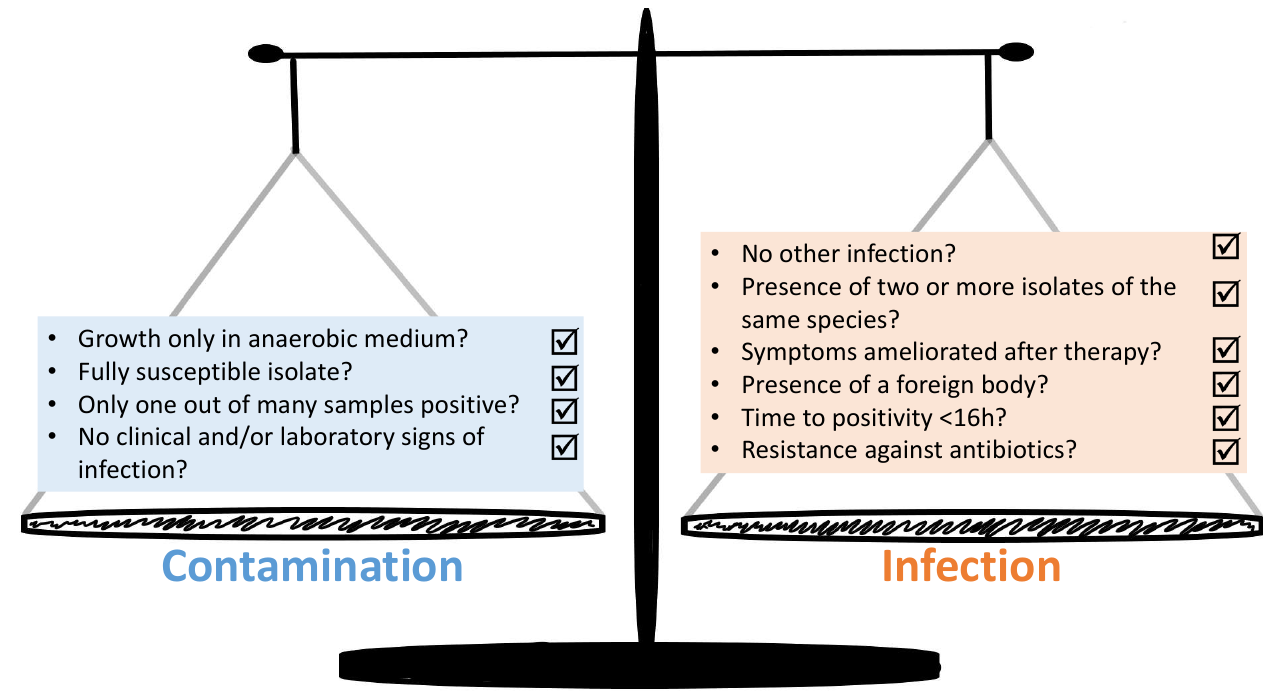
Figure 2. Model for differentiation between contamination and infection pertaining to the finding of CoNS in a primary sterile material; BC: blood culture.